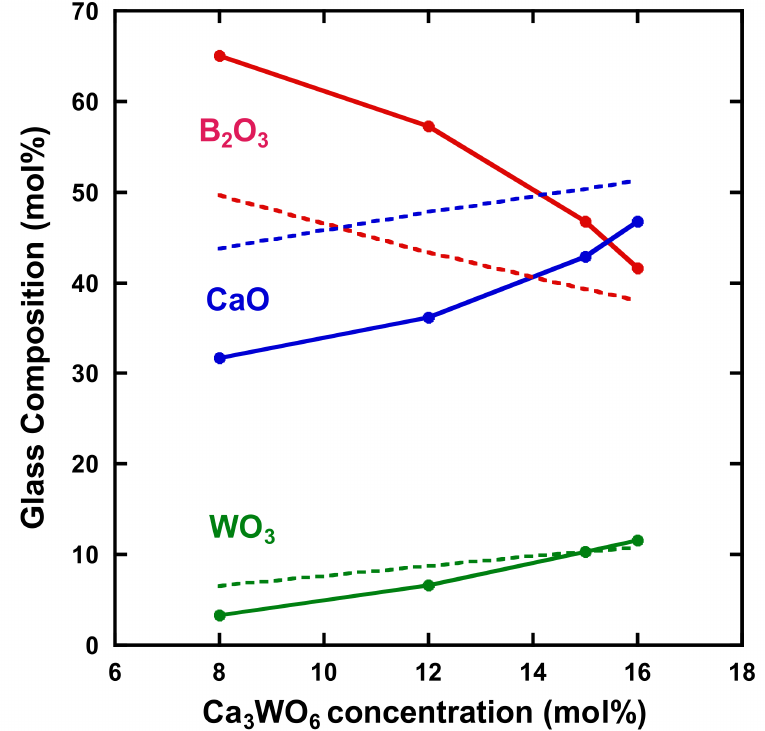
Figure 4. Glass composition estimated by EDS measurements for (100 − x ) (33CaO-67B 2 O 3 ) − x Ca 3 WO 6 (dashed and solid lines show theoretical and experimental contents,